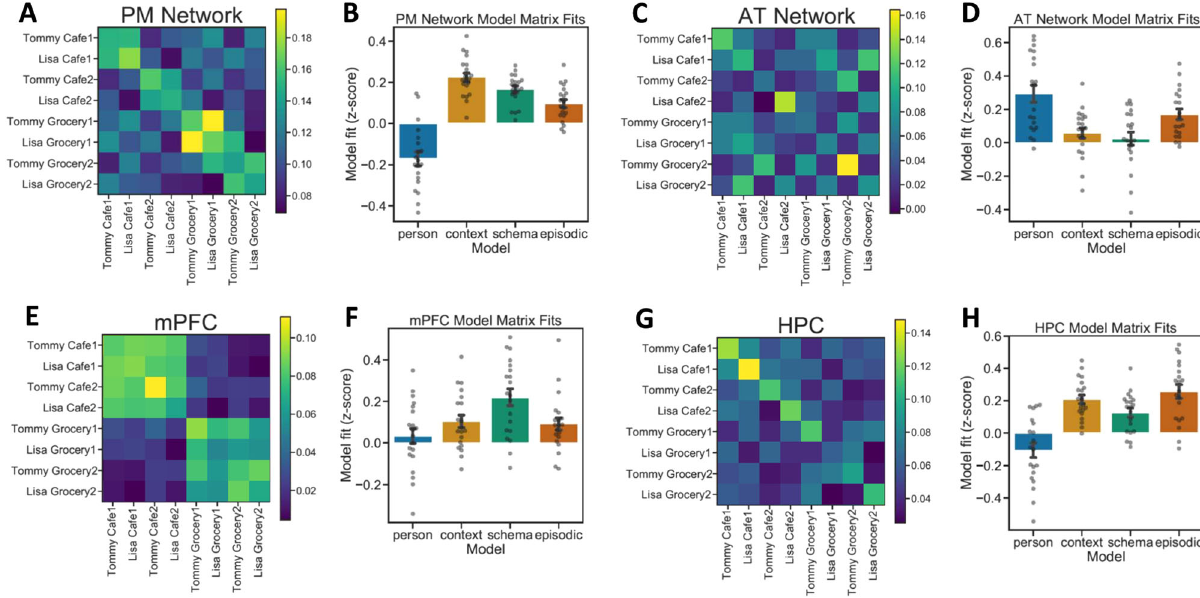
Fig. 5 | Content-selective pattern reinstatement across ROIs during spoken recall. A , B PM Network pattern reinstatement most strongly fi ts the Context modelmatrix. C , D ATNetworkpatternreinstatementmoststrongly fi tsthePerson